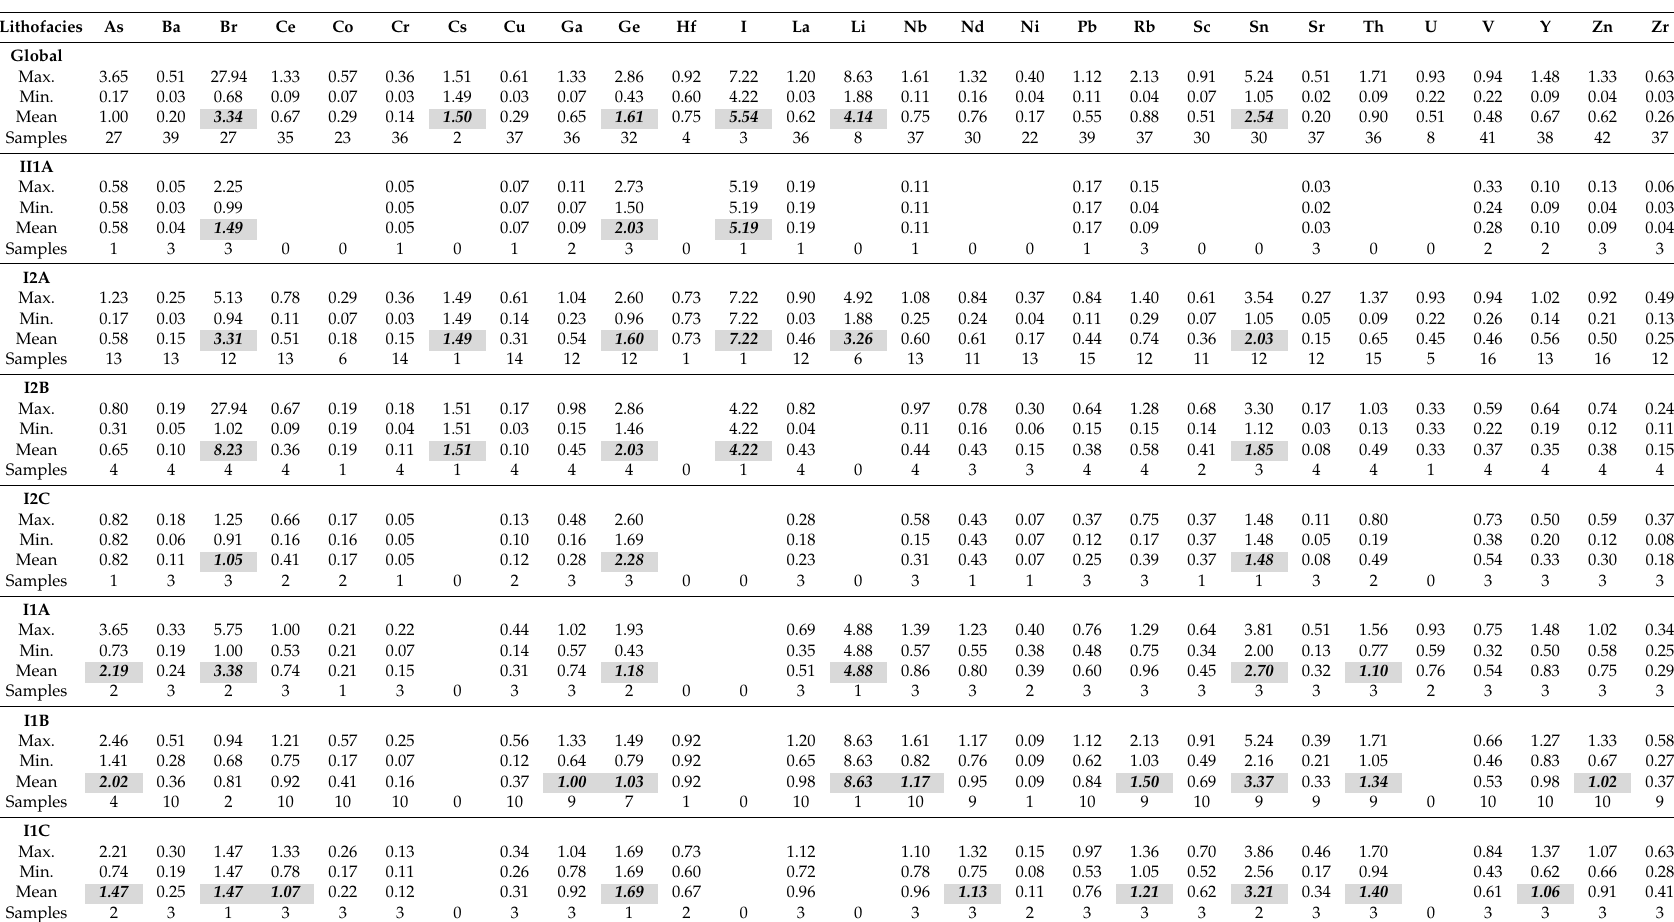
Table A4. Summary of the maximum, minimum and mean values of the data obtained from the normalization of trace elements with the Upper Continental Crust (UCC) composition. The highlighted average values (bold on a blue background) indicate enrichment with respect to the UCC. Lithofacies As Ba Global